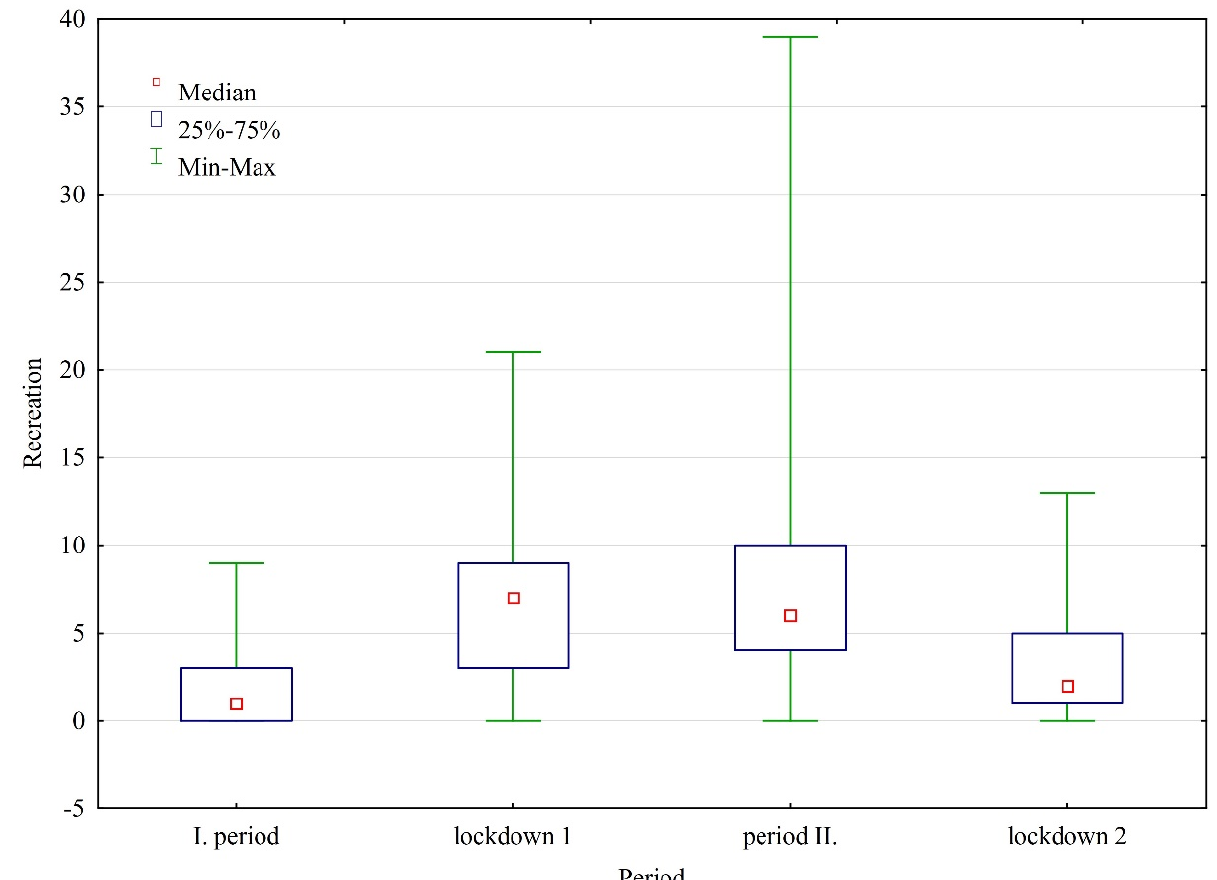
Figure 3. Kruskal–Wallis ANOVA comparison of median values of the daily number of recreational activities in periods of lockdown and of unrestricted movement, p = 0.000.